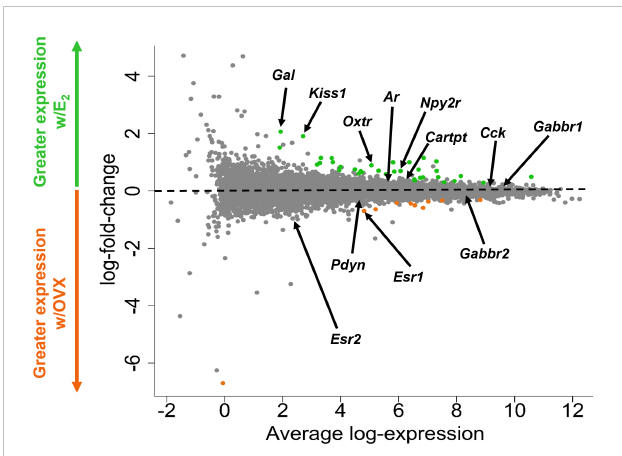
FIGURE 3 A glimma plot showing the expression of >13,800 gene transcripts identi fi ed by RNA-seq to be produced in MeA Kiss1 cells. Each dot represents a single gene transcript. Some transcripts were upregulated by E 2 treatment (green dots), whereas other transcripts were downregulated by E 2 treatment (orange dots). Grey dots represent gene transcripts whose expression did not differ between OVX and E 2 treatment groups. The y-axis represents the magnitude of difference in expression levels between OVX and E 2 samples, with greater positive or negative values indicating a greater difference in gene expression between the two treatment groups. Y-axis values close to 0 indicate little change in expression levels between OVX and E 2 treatments. The x-axis represents the average log-expression of each transcript, thus plotting the average of the mean expression levels of the OVX and E 2 treatment groups. Several genes of interest are marked by arrows to indicate their location in the glimma